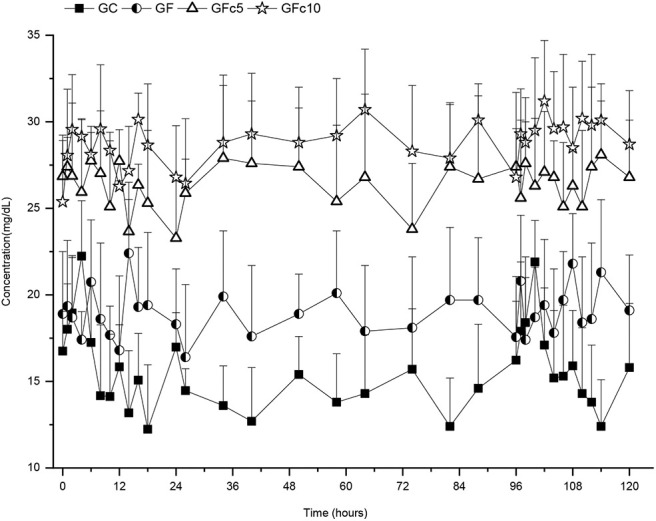
Five days calcium serum concentrations achieved with four calcium sources administered orally in 85-week-old Bovans-White hens: control group (GC), receiving a diet containing basal levels of 4.1% of calcium-carbonate; group GF treated as GC, but including the same dose of calcium-carbonate in FOLA pellets; group GFc5 treated as GF, but adding 6 ppm of capsicum-oleoresin (500,000 Scoville Heat Units [SHU]), and group GFc10 treated as GFc5 but with 1,000,000 SHU capsicum-oleoresin.